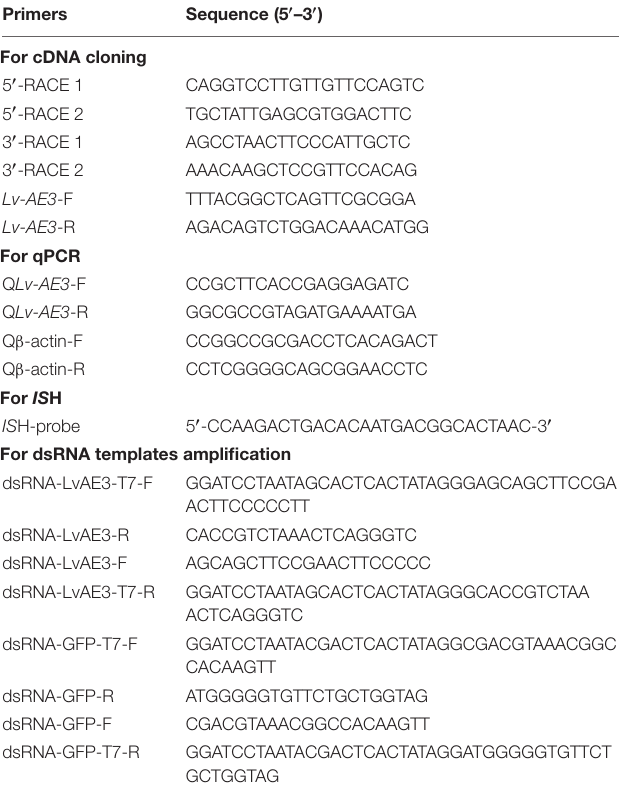
TABLE 1 | Nucleotide sequences of primers used in this study.